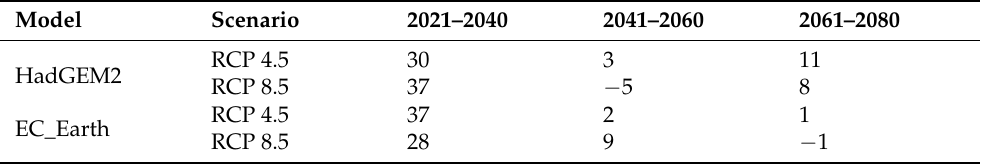
Table 6. Summary of percentage change in TP load during 2021–2040, 2041–2060 and 2061–2080 for